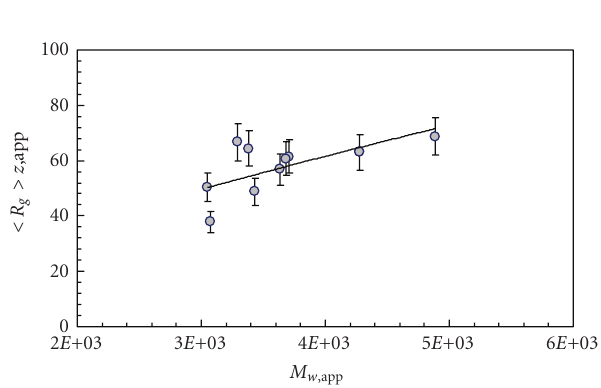
Figure 4: The experimental power law for guanosine 1 is 0.75, higher than the value for regular swollen coil 0.6 (for the apparent Molecular weight ( (cid:3) )) and is the signature for a rigid object (error bars of 10%). (cid:3) R g (cid:4) z ,app is a statistical value of the gyration radius depending on the mass and number of monomers in the polymer (see [64]).